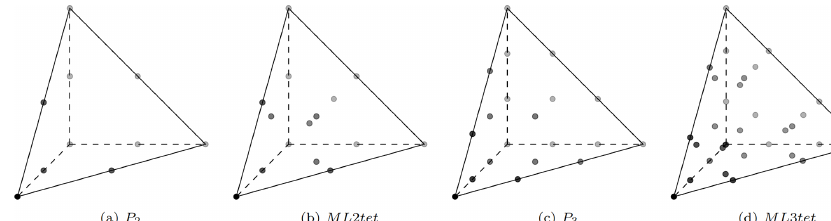
Figure 3. Some three-dimensional Lagrange and ML elements.